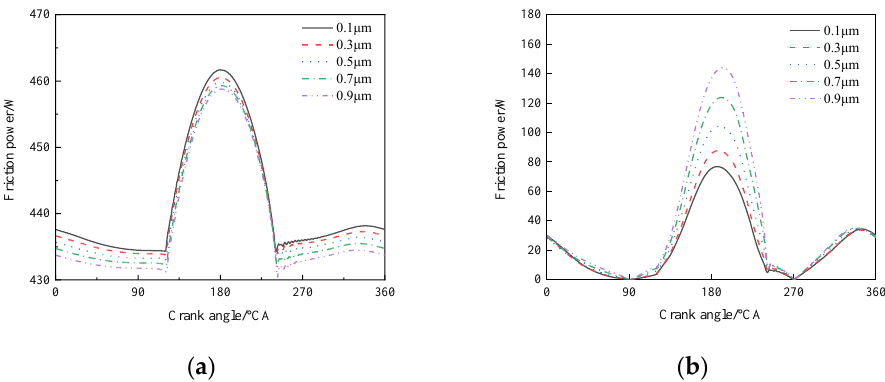
Figure 16. ( a ) Hydrodynamic lubrication friction power in different bushing roughnesses. ( b ) Asperity contact friction power in different bushing roughnesses.